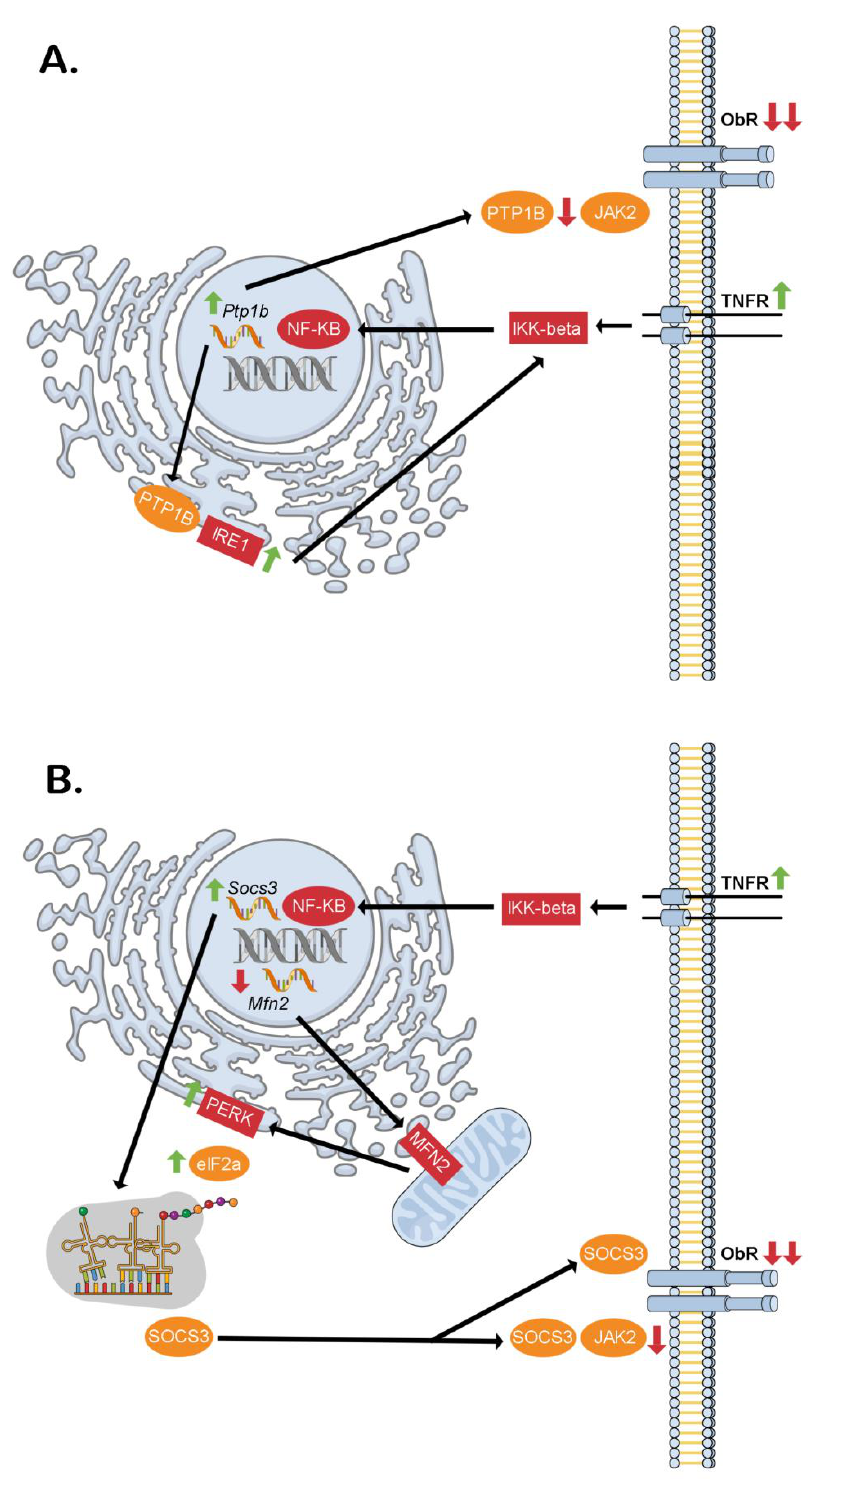
FIGURE 2: Proposed intracellular signaling cascades liking inflamma- tion, ER stress and